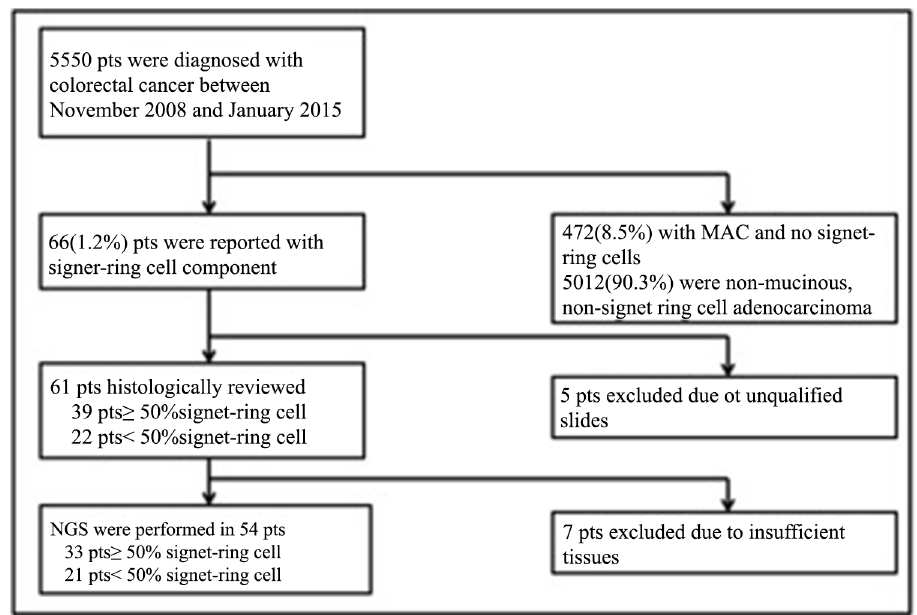
Fig 1. Work Flow Chart. pts = patients; NGS = next-generation sequencing; MAC = mucinous